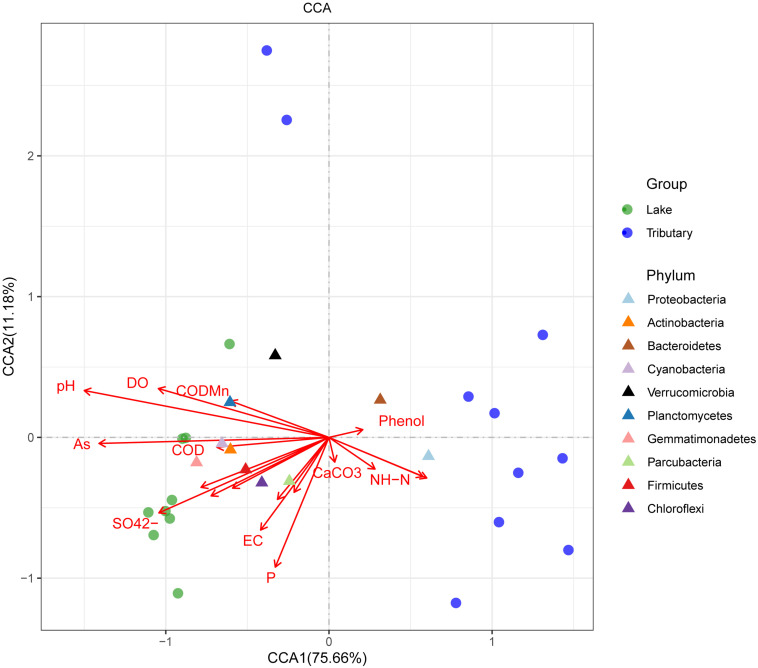
Canonical correlation analysis at the phylum level (by group). The length of the arrow of different environmental factors represents the degree of correlation between the corresponding environmental factor and the sample.